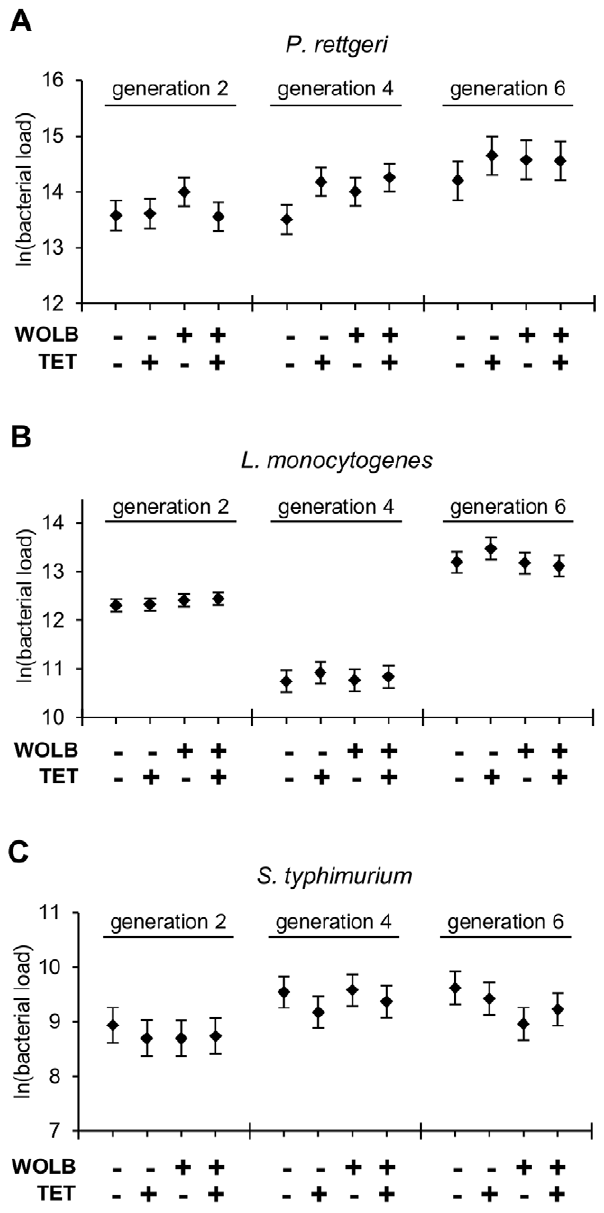
Figure 1. Systemic bacterial load is not influenced by Wolbachia infection. Least squares means for bacterial load ( 6 1SE) of five Wolbachia -infected lines [WOLB( + )TET(-)] and genetically matched lines that have been cured of Wolbachia [WOLB( + )TET( + )], as well as five Wolbachia -uninfected lines [WOLB(-)TET(-)] and genetically paired tetracycline treated lines[WOLB(-)TET( + )]. Note that the WOLB category on the x-axis refers to initial Wolbachia -infection status prior to antibiotic treatment, rather than infection status at the time of experimental infections. Bacterial load was measured 24 hours after infection with the pathogenic bacteria (A) P. rettgeri (B) L. monocyto- genes and (C) S. typhimurium . Assays were performed 2, 4, and 6 generations after ending tetracycline treatment, with three replicates in each generation. For each replicate, bacterial load was measured in 3 pools of 5 flies from every line.